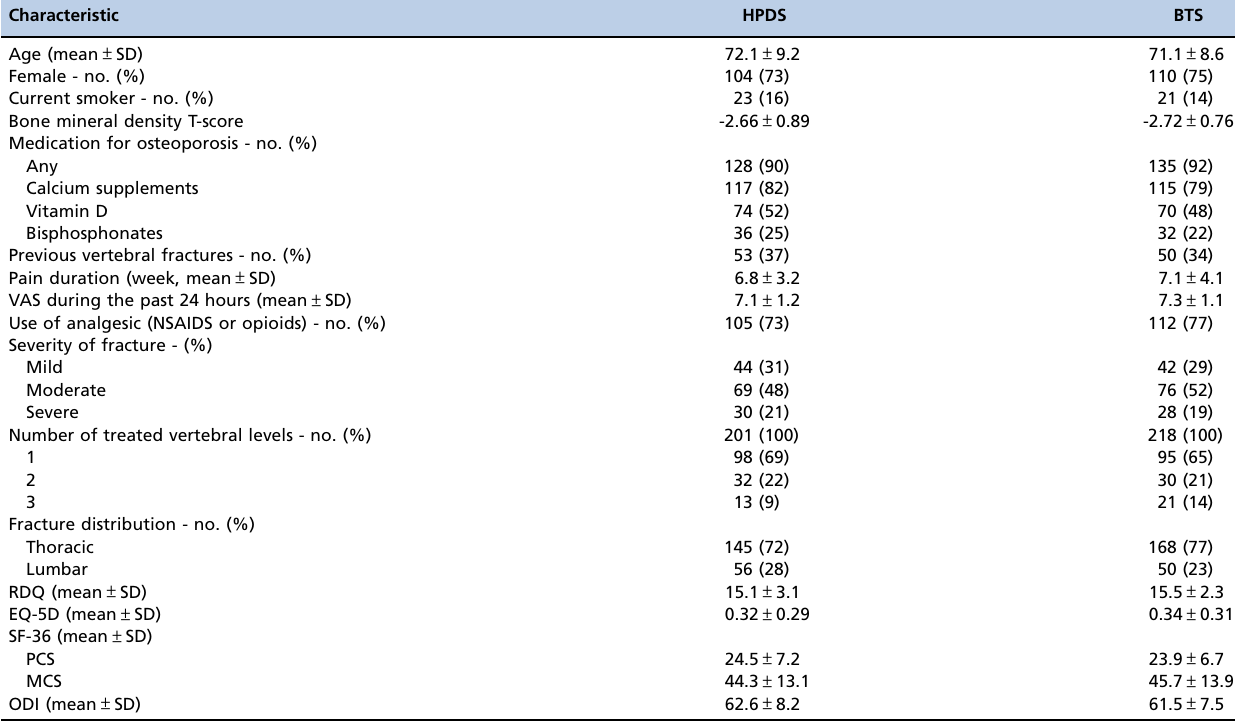
Table 1 - Baseline characteristics and clinical data of the patients. Characteristic